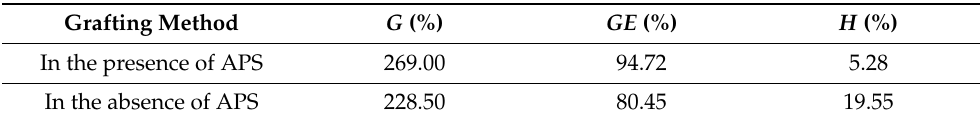
Table 2. Effect of APS initiator on grafting parameters (power = 750 Watt; t = 100 s; mXan = 0.2 g/L; mAAm = 8.0 mmol).